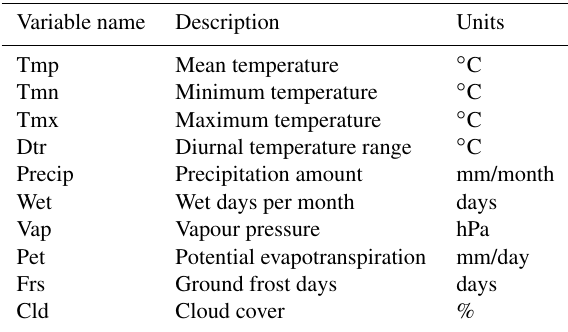
Table 1. Meteorological variables and their descriptions.